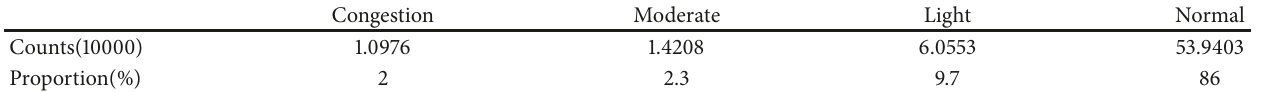
Table 1: The data components of the 4 passenger traffic patterns.